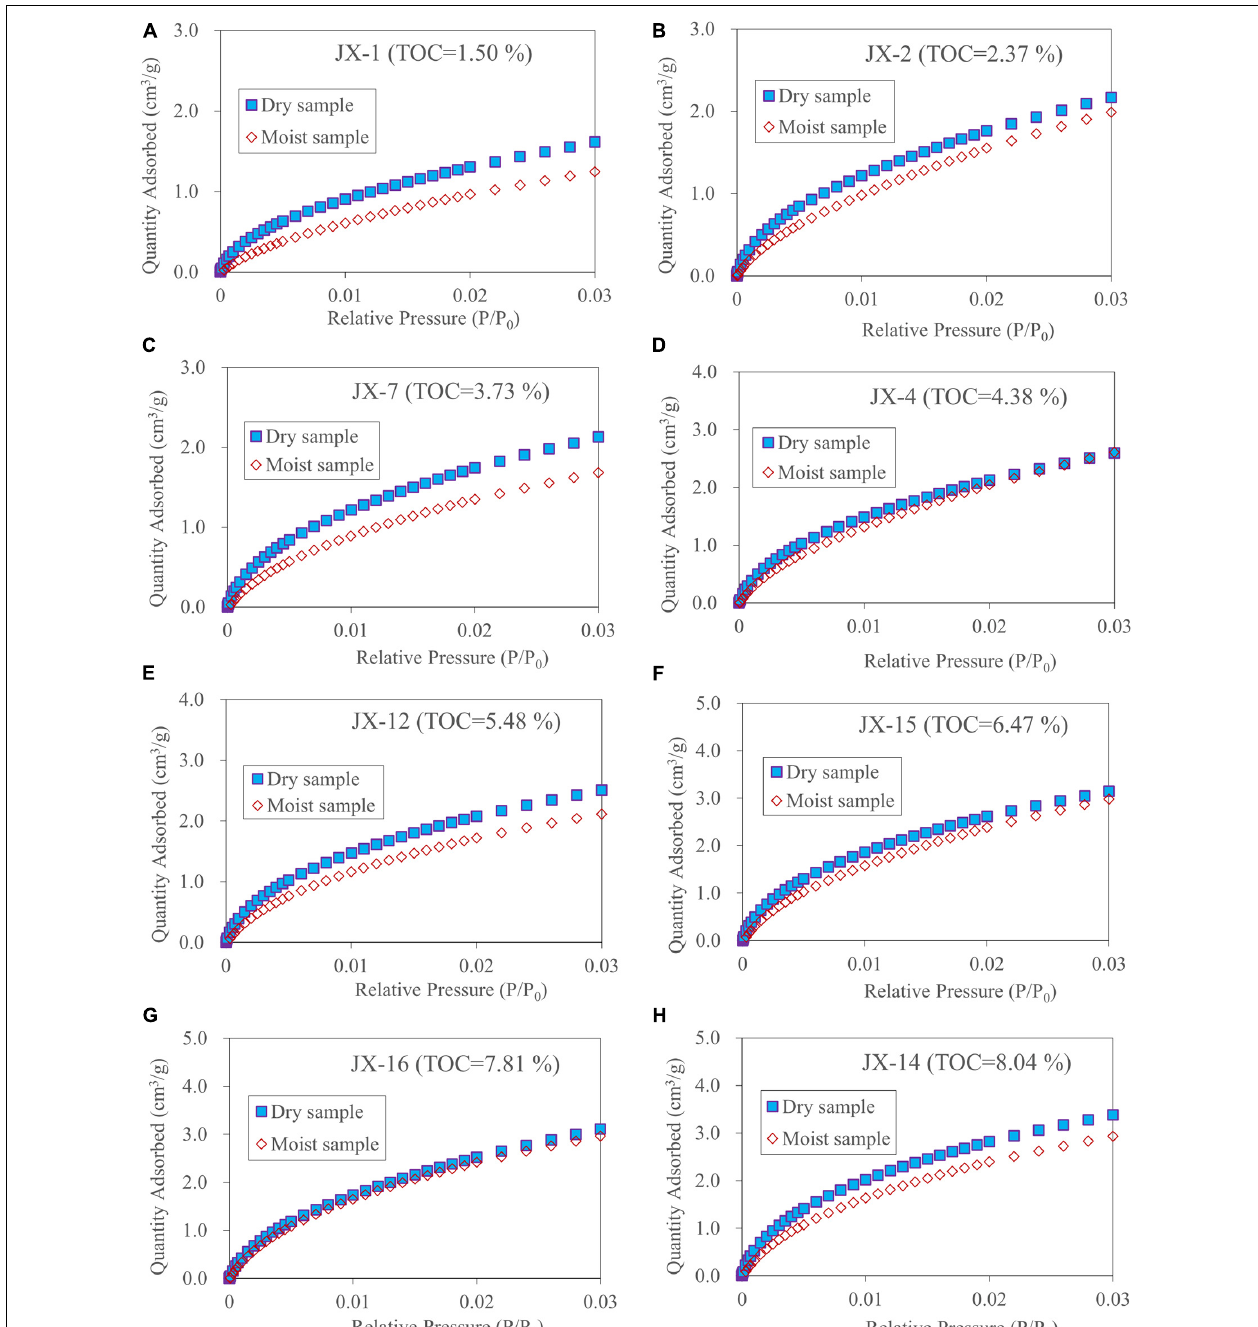
FIGURE 4 | Plots showing the low-pressure CO 2 adsorption isotherms of the selected 8 pairs (dry and moist) samples (A–H) . The adsorption isotherm shape and adsorption quantity of the moist sample are close to those of the corresponding dry sample, implying a small effect of irreducible water on micropores.